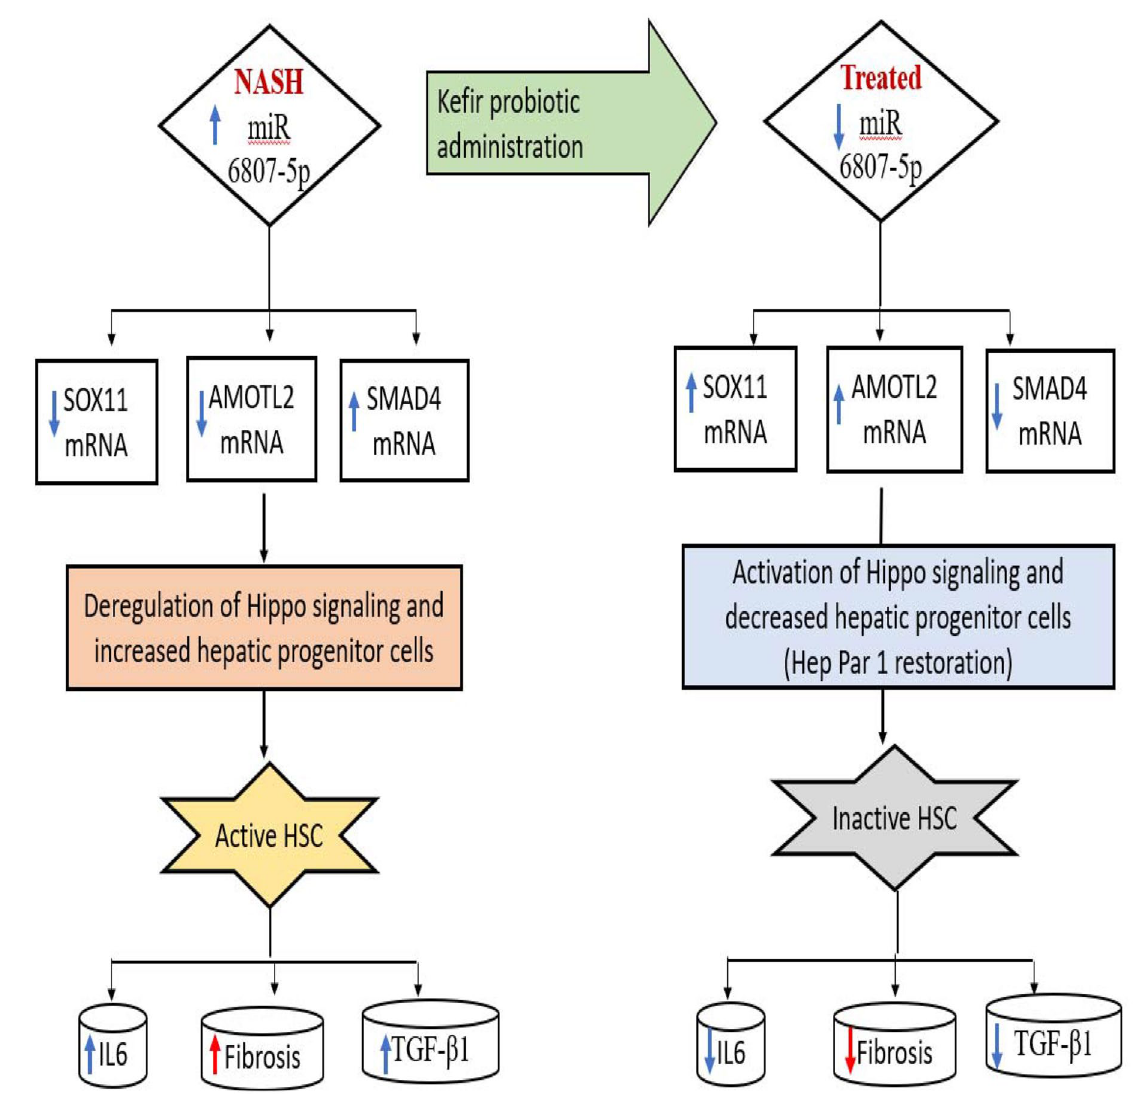
Figure 7. Proof of concept map of the study